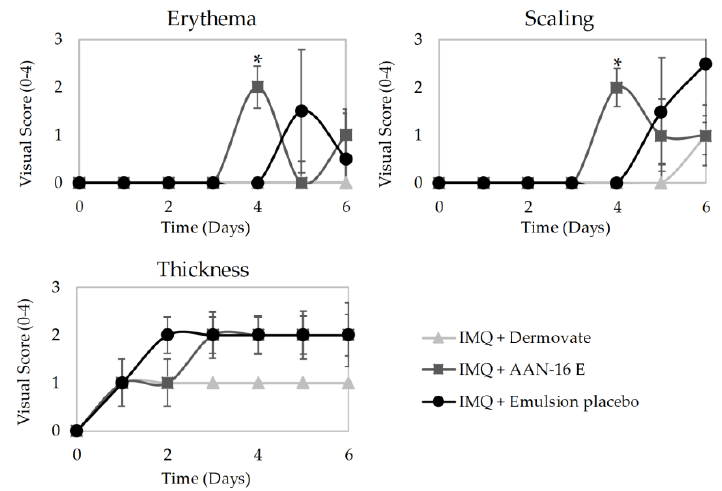
Figure 6. Results of the in vivo antipsoriatic activity: erythema, scaling and skin thickness of mice challenged with imiquimod (IMQ) and treated with each formulation (Dermovate ® , AAN-16 E and emulsion placebo). Score 0–4 (none to marked). Results expressed as average ± SD.